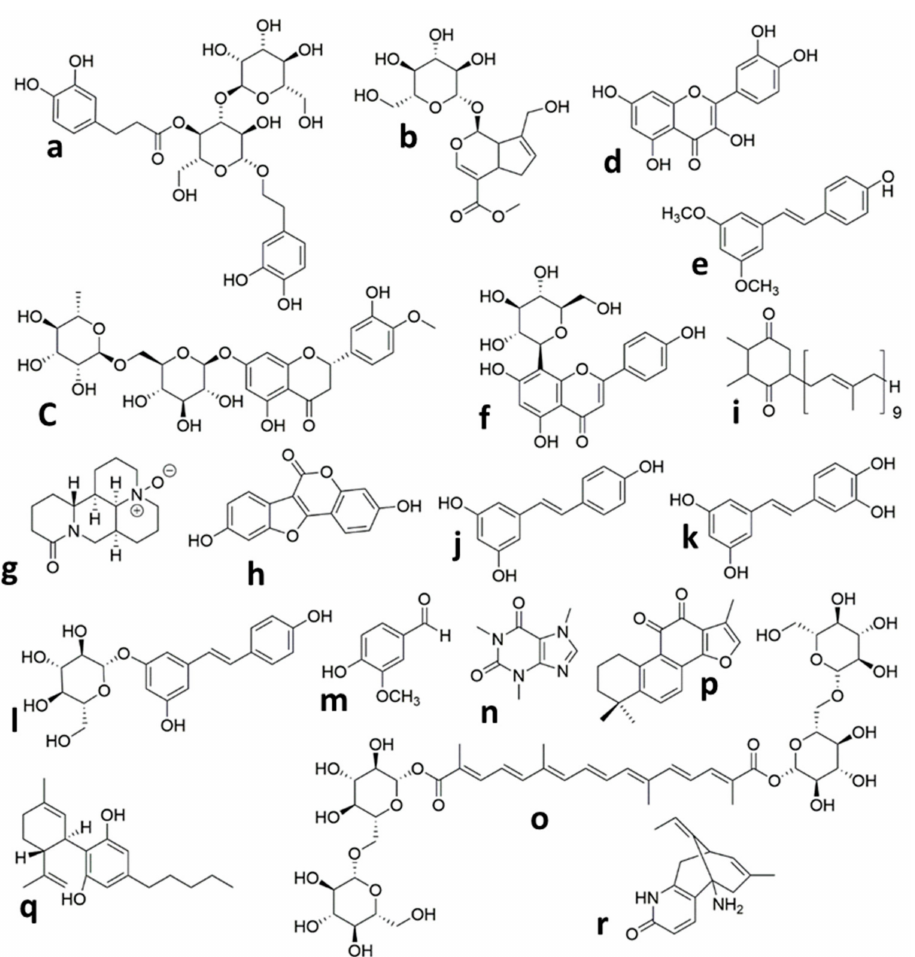
Figure 1. Chemical structures of the isolated compounds from plants in animal models of neonatal Hypoxic Ischemic brain injury. ( a ) Verbascoside, ( b ) Geniposide, ( c ) Hesperidin, ( d ) Quercetin, ( e ) Pterostilbene, ( f ) Vitexin, ( g ) Oxymatrine, ( h ) Coumestrol, ( i ) Plastoquinone, ( j ) Resveratrol, ( k ) Piceatannol, ( l ) Polydatin, ( m ) Vanillin, ( n ) Caffeine, ( o ) Crocin, ( p ) Tanshinone IIA, ( q ) Cannabidiol, ( r ) Huperzine